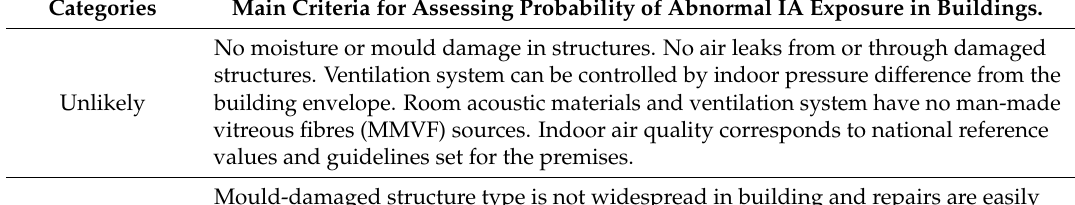
Table 1. Main criteria and categories for assessing probability of abnormal IA exposure in buildings.